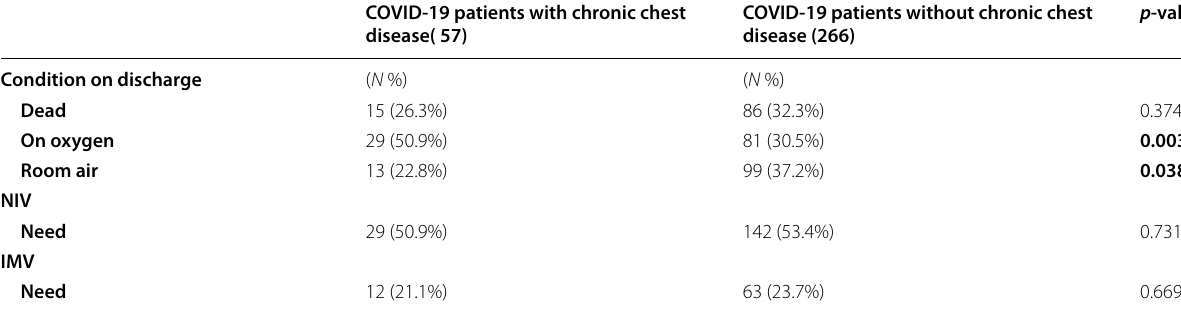
NIV Noninvasive ventilation, IMV Invasive mechanical ventilation